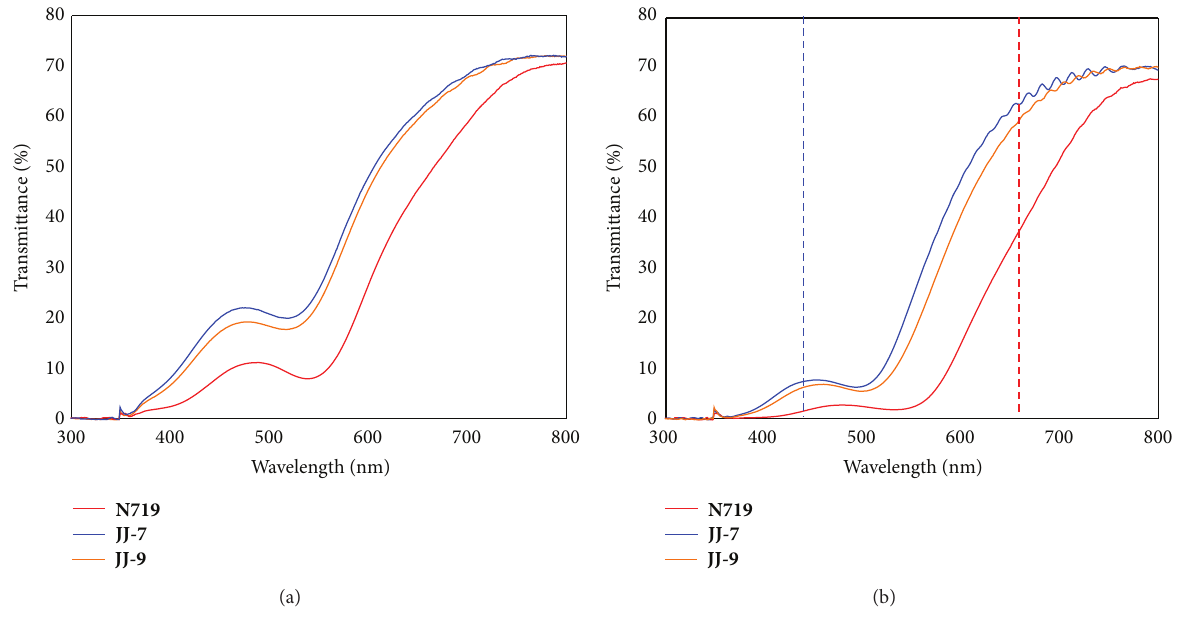
Figure 5: Transmittance spectra of JJ-7 (blue line), JJ-9 (orange line), and N719 (red line) (a) adsorbed on 5 𝜇 m TiO 2 film and (b) adsorbed on 10 𝜇 m TiO 2 film.